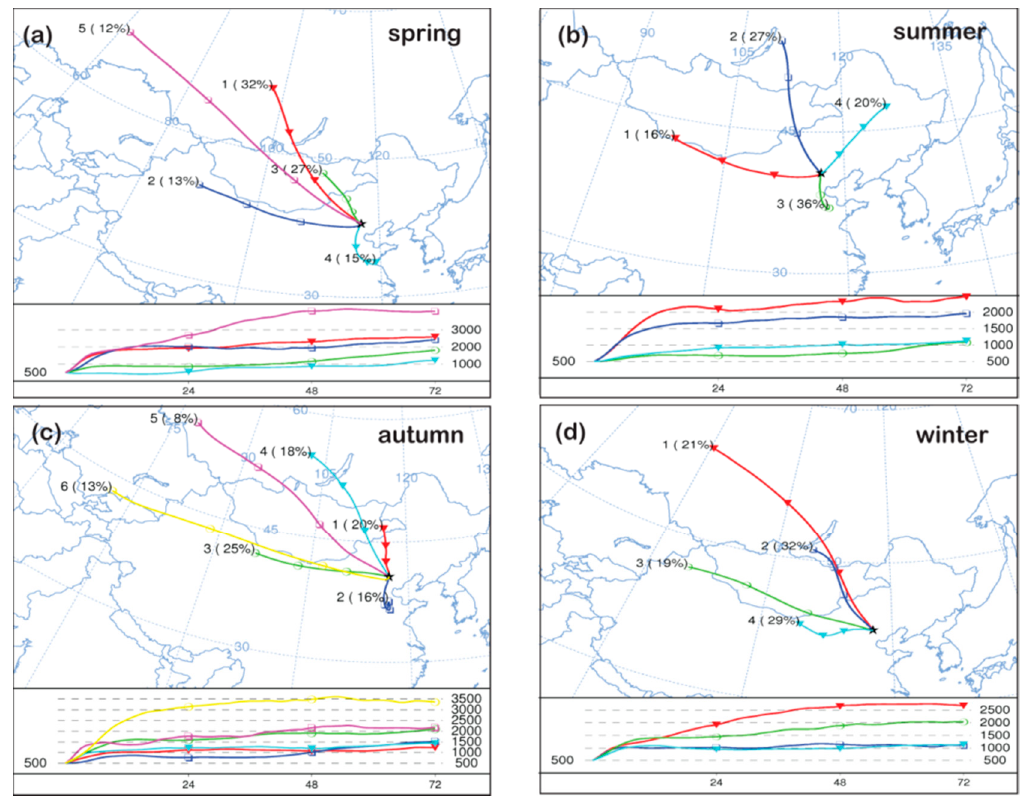
Figure 7. Analytical results of 72 hair mass back trajectories arriving at 500 m elevation at SDZ station in spring ( a ); summer ( b ); autumn ( c ) and winter ( d ).